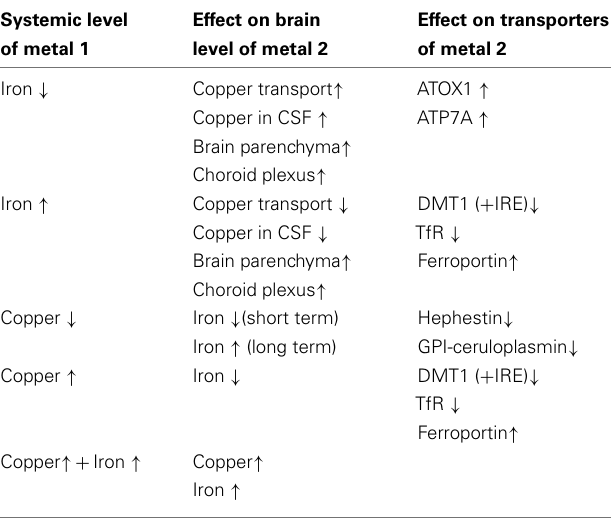
Table 2 | Effect of high or low systemic levels of metal 1 on the level of metal 2 in the brain and on transporters of metal